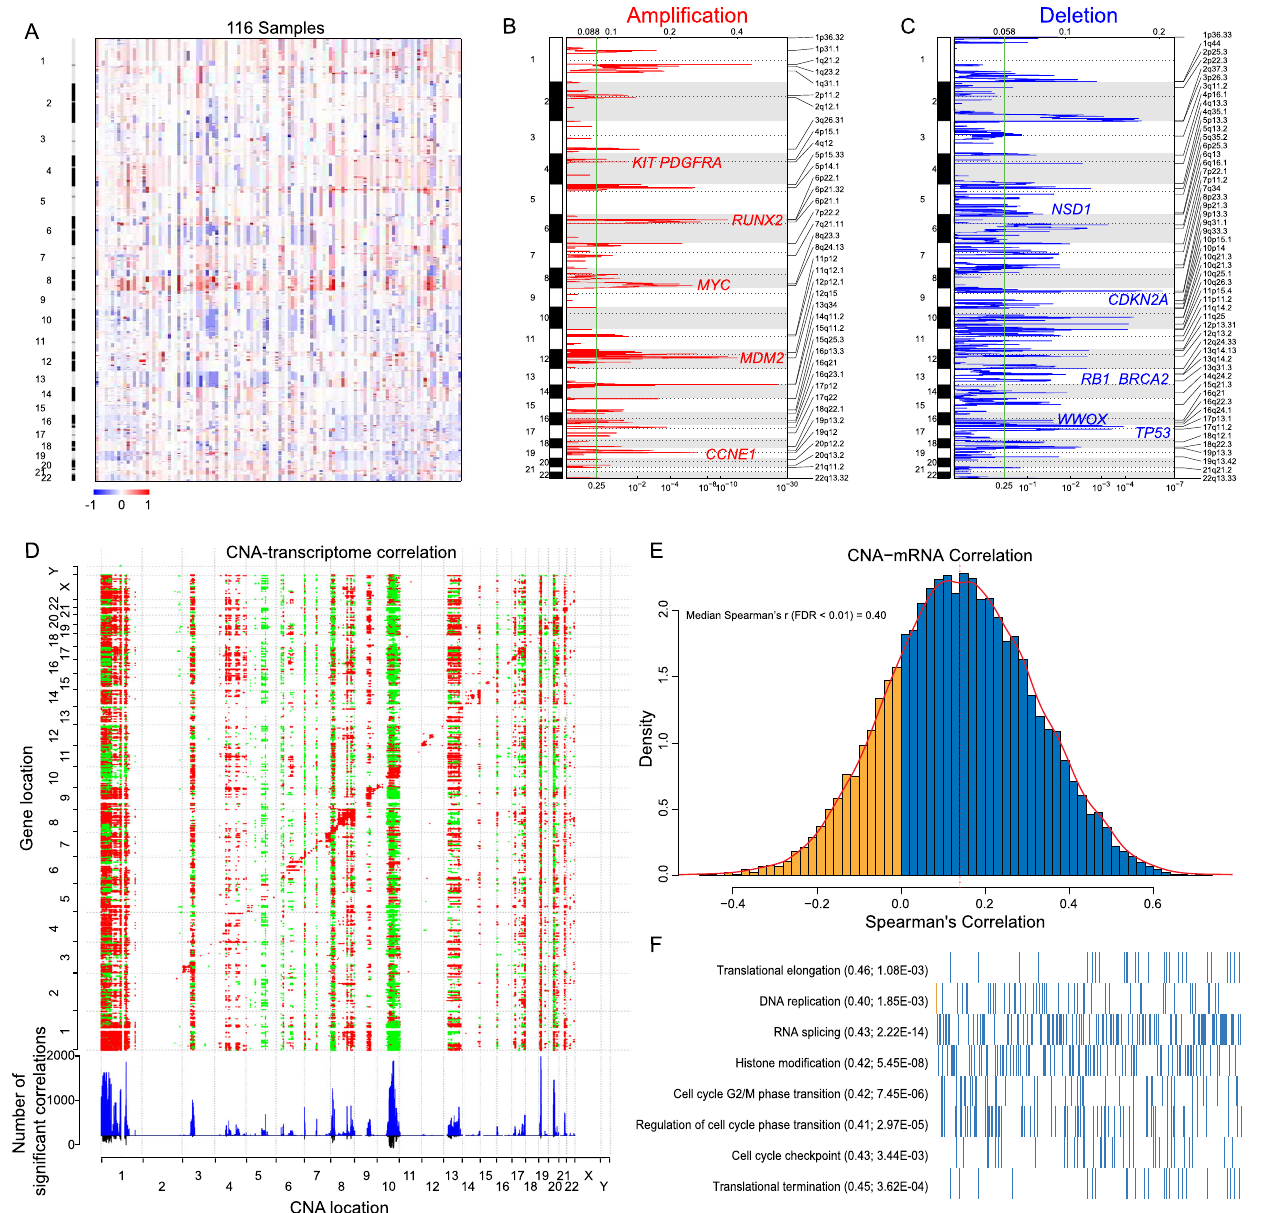
Fig. 2 | Copy number alteration pro fi les ofOS. A Heatmap of the CNAsof 116 OS tumor samples: red and blue represent copy number gain and loss, respectively. The x axis indicates the 116 tumor samples. B Genome-wide recurring focal ampli fi cations with GISTIC 2.0 FDR q values on the bottom. Peaks were annotated with candidate driver oncogenes in red. C Genome-wide recurrent focal deletions with GISTIC 2.0 FDR q values on the bottom. Candidate driver tumor suppressors within deletion peaks are labeled in blue. D Correlations of CNAs to mRNA expressionwith cis and trans effects.Signi fi cantpositive(red)andnegative(green) correlations (see “ Methods ” , FDR<0.01, Spearman ’ s correlation) between CNAs and mRNA are indicated in the upper panel. The X-axis and Y-axis are ordered by